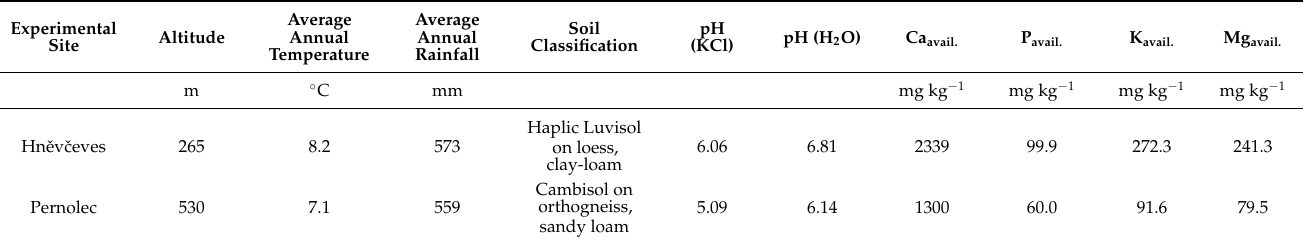
Table 1. Experimental site characteristics with available nutrients (average values over the experi- mental